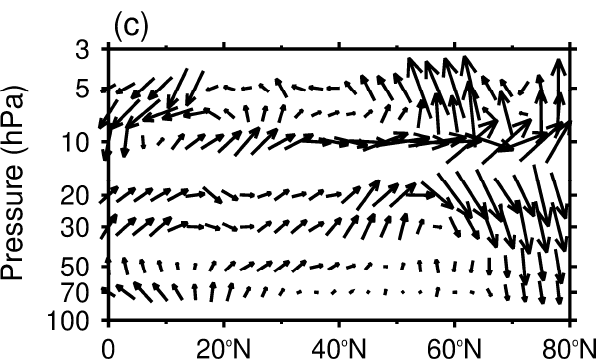
Figure 9. ( a ) Variation in HCl (black line) and N 2 O (red line) from January 1986 to December 1987 based on SLIMCAT model simulation. ( b ) Latitude–height cross ‐ sections of the residual circulation anomaly averaged in ( b ) November–December 1986 and ( c ) January–February 1987. The vertical component of the residual circulation was multiplied by 500.